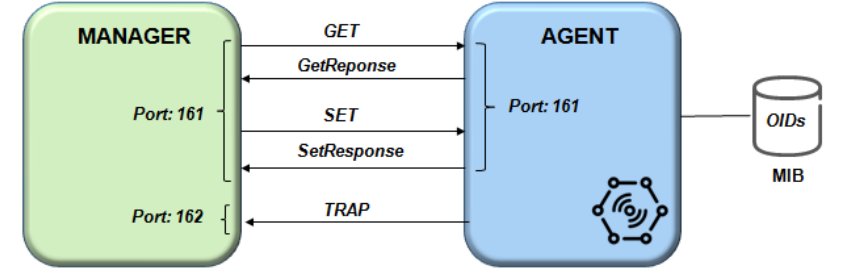
Figure 5. Illustration of the SNMP Protocol